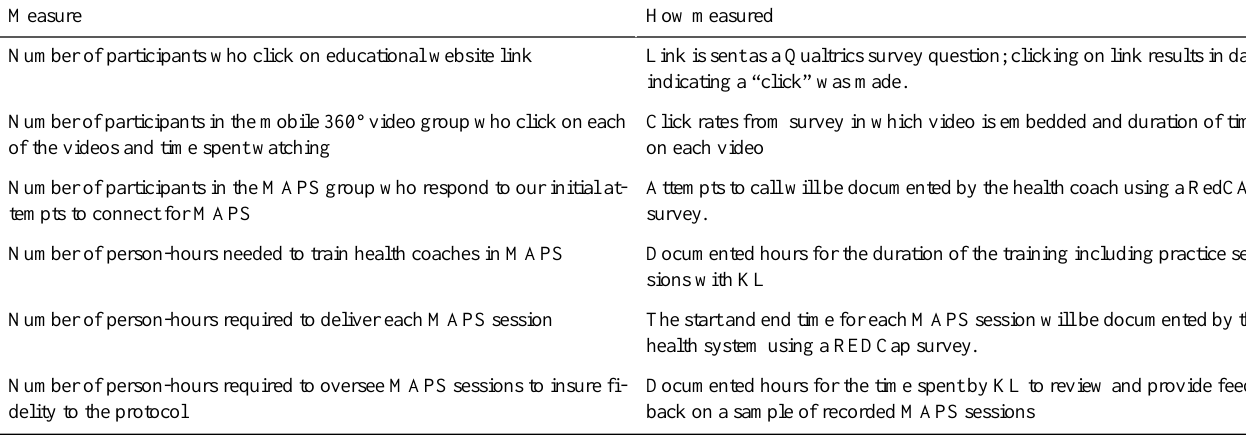
Table 2. Process measures collected by study staff. made.Number of participants who click on educational website link videoNumber of participants in the mobile 360° video group who click on each of the videos and time spent watching tempts to connect for MAPS KLNumber of person-hours needed to train health coaches in MAPS survey.Number of person-hours required to deliver each MAPS session